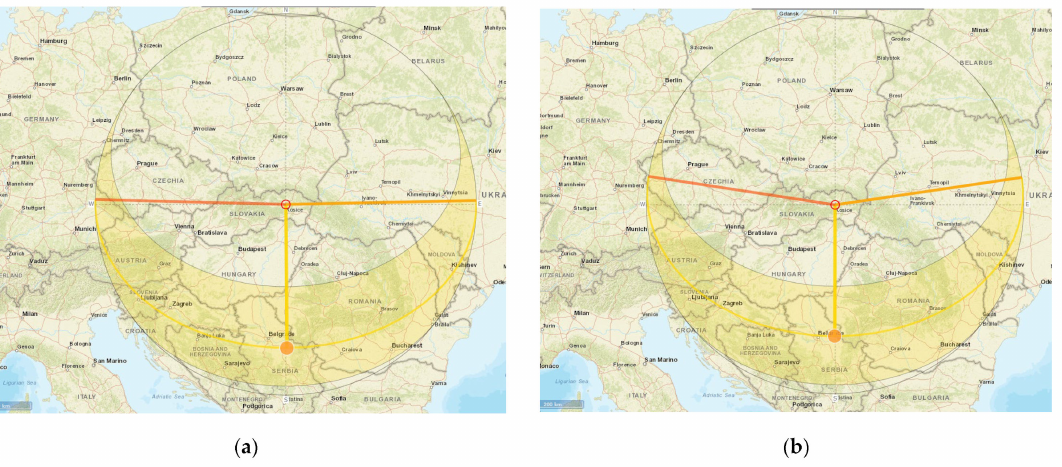
Figure 9. The path of the Sun at the experimental site during selected months (March; April, displayed day ( a ) 21.3; ( b ) 2.4)